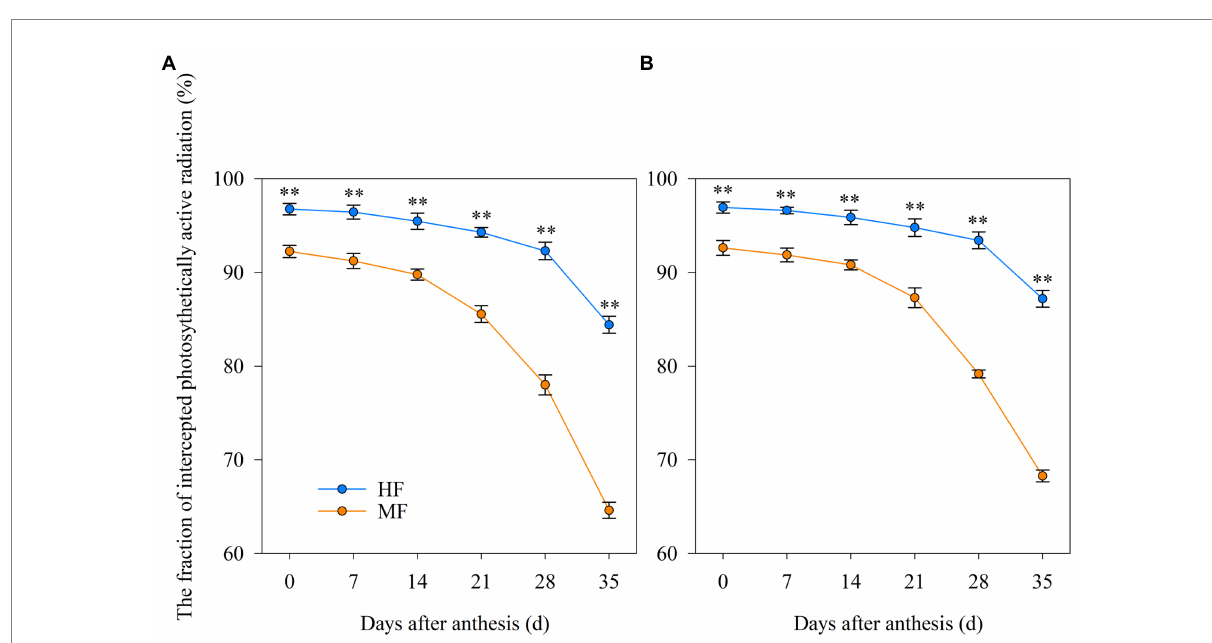
FIGURE 3 Dynamics of the intercepted photosynthetically active radiation fraction of wheat after anthesis in 2017/18 (A) and 2018/19 (B) . HF, high soil fertility field and MF, middle soil fertility field. Vertical bars represent the SD of the means. ** p < 0.01.